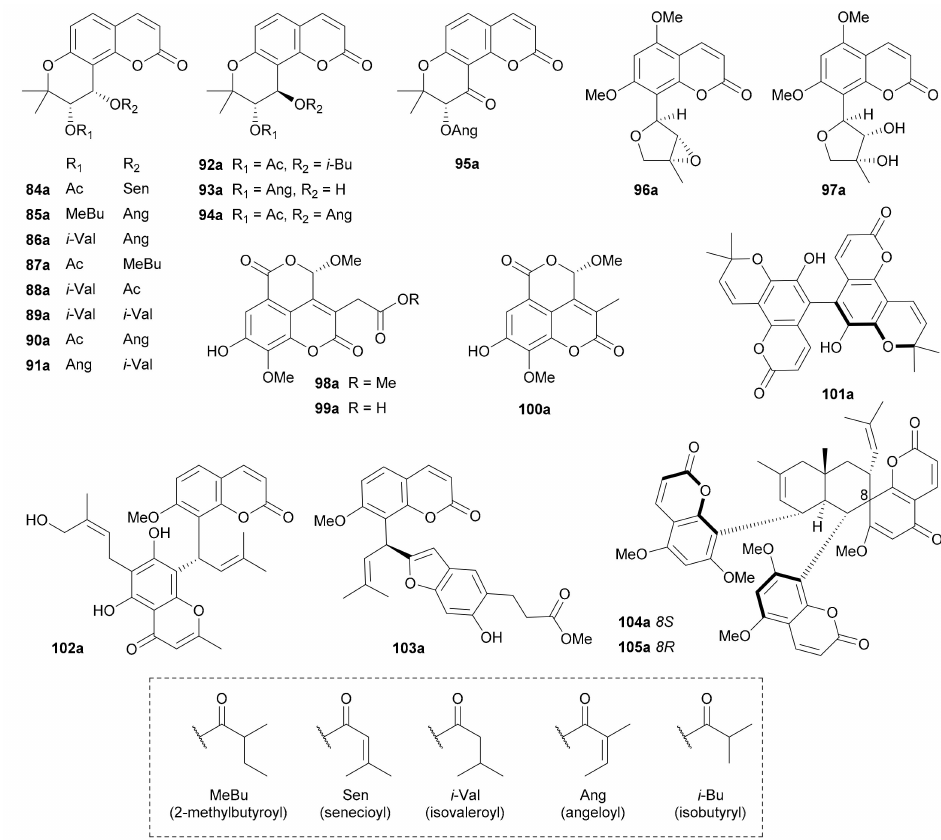
Figure 6. Structures of